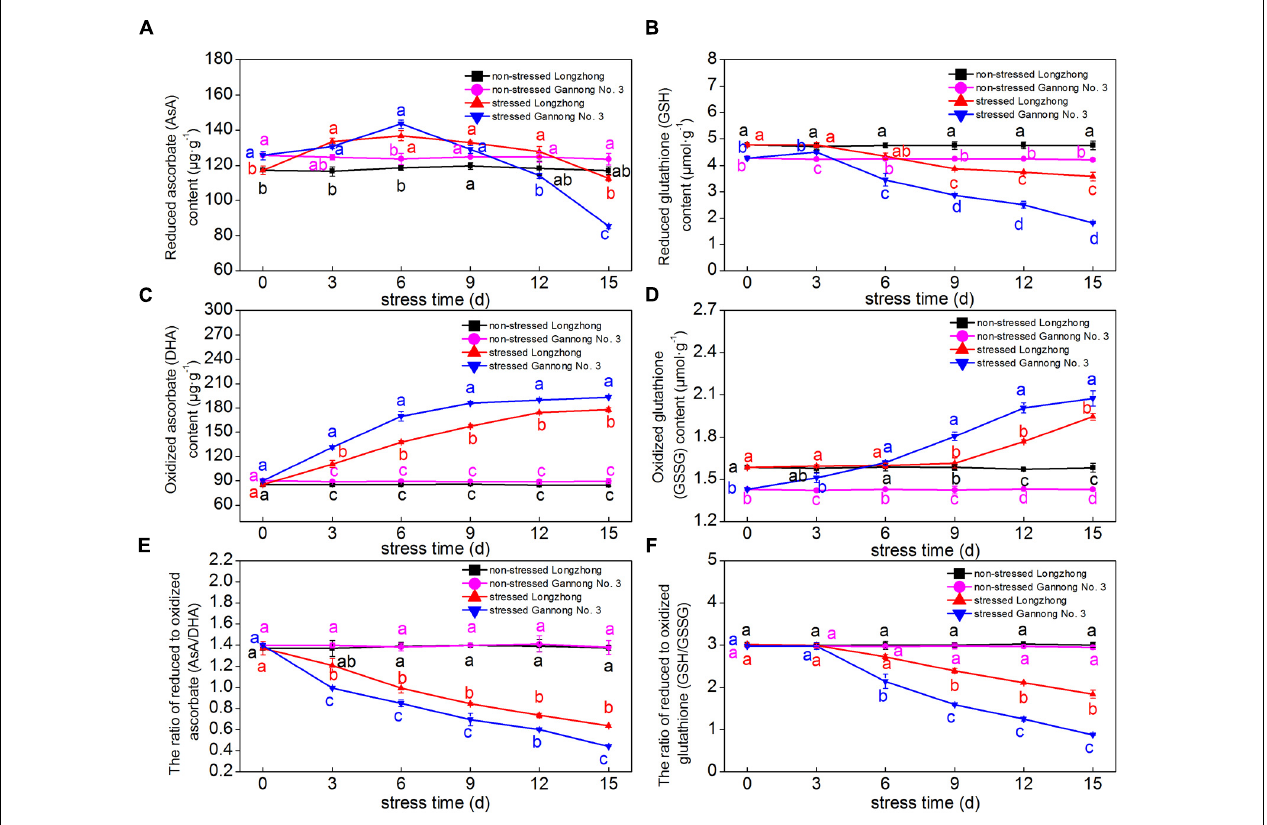
FIGURE 4 | Changes of the contents of antioxidants (AsA, DHA, GSH, GSSG) (A–D) , and the ratios of AsA/DHA (E) and GSH/GSSG (F) in two alfalfa varieties under non-stressed and stressed conditions at different time points. Different letters above line graphs indicate significant difference among treatments at a given day of treatment ( P ≤ 0.05), and vertical bars indicate ± SE of mean ( n =